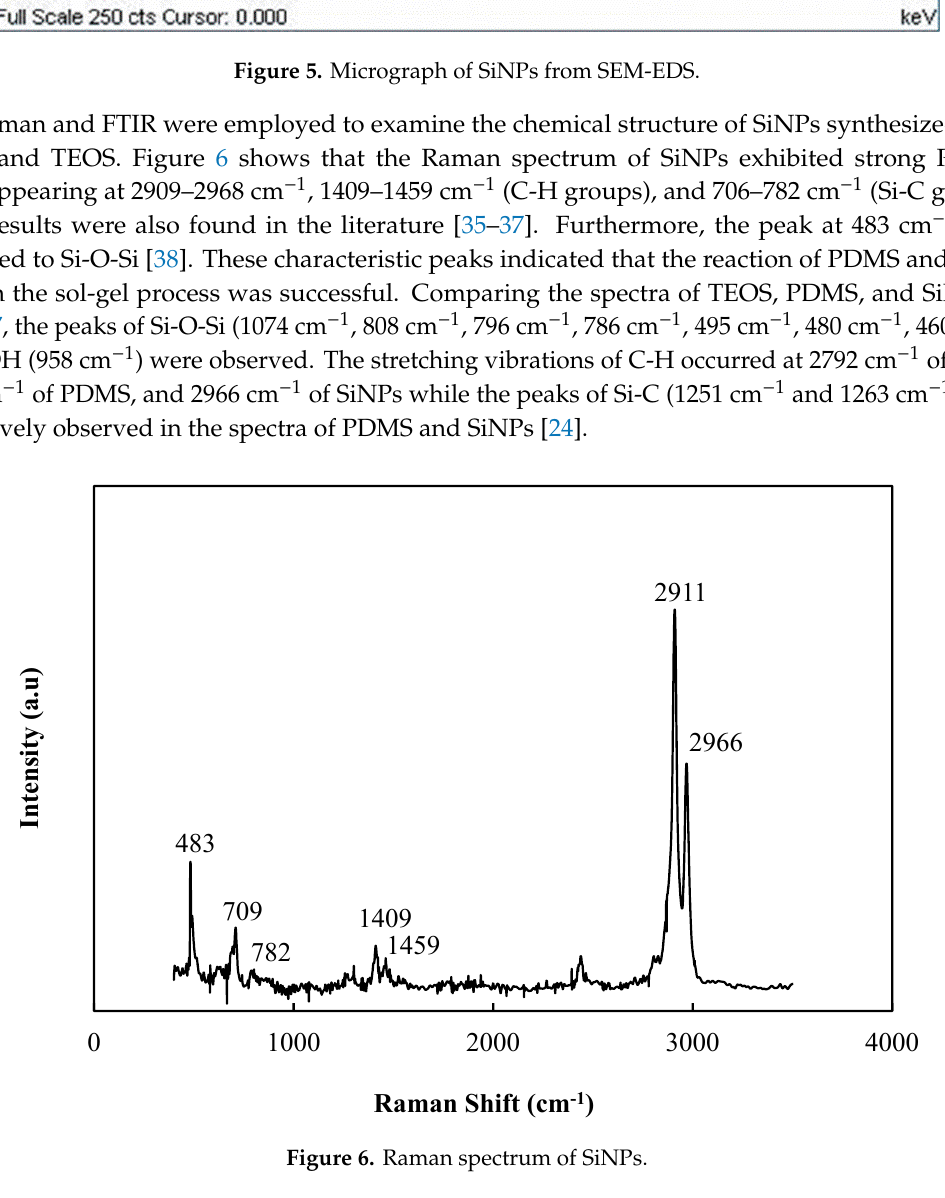
Figure 7. FTIR spectra of TEOS, PDMS, and SiNPs. 3.2. Optical Transparency Figure 8 shows the photos of hydrated soft lenses including poly(HEMA-co-NVP) and poly(HEMA-co-NVP)-SiNPs. These lenses appeared transparent.